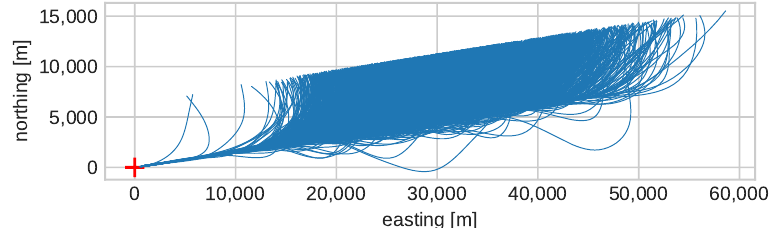
Figure 4. The flight tracks that are part of the data set that is used for this study. The red cross depicts the runway